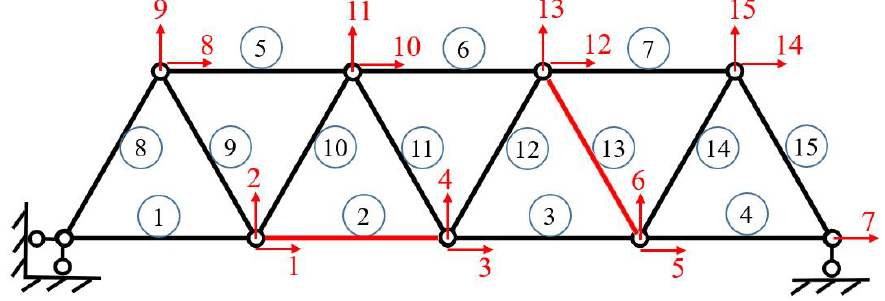
Figure 13. Truss structure model.